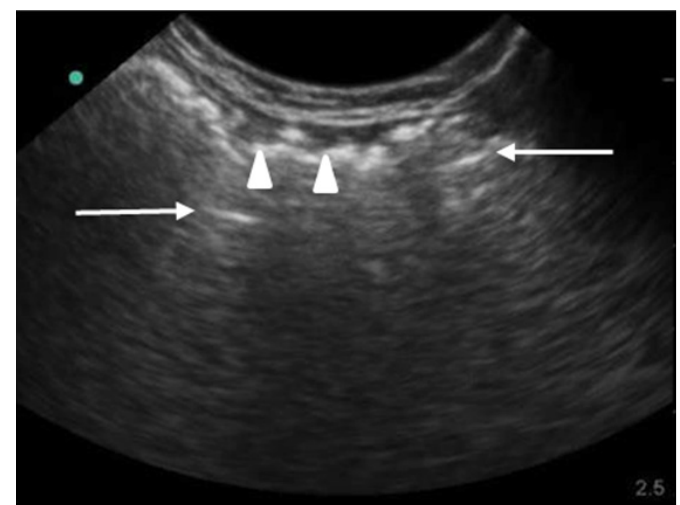
Image 3 . Point-of-care ultrasound of the neck done by the emergency physician, showing hyperechoic soft-tissue emphysema (arrowheads) with posterior acoustic shadowing and reverberation artifacts